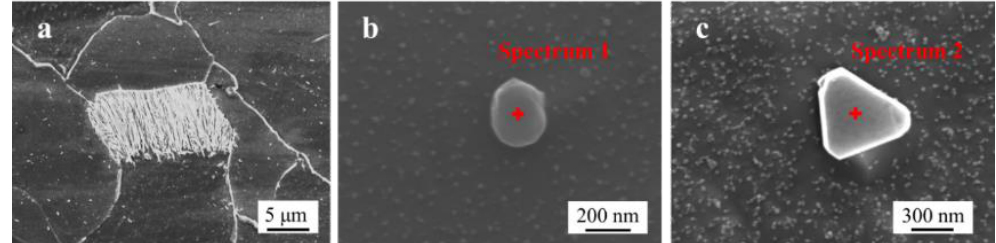
Figure 2. SEM images of different microstructures in the steel: ( a ) pearlite in the steel; and ( b , c ) nanoscale inclusions in the steel.